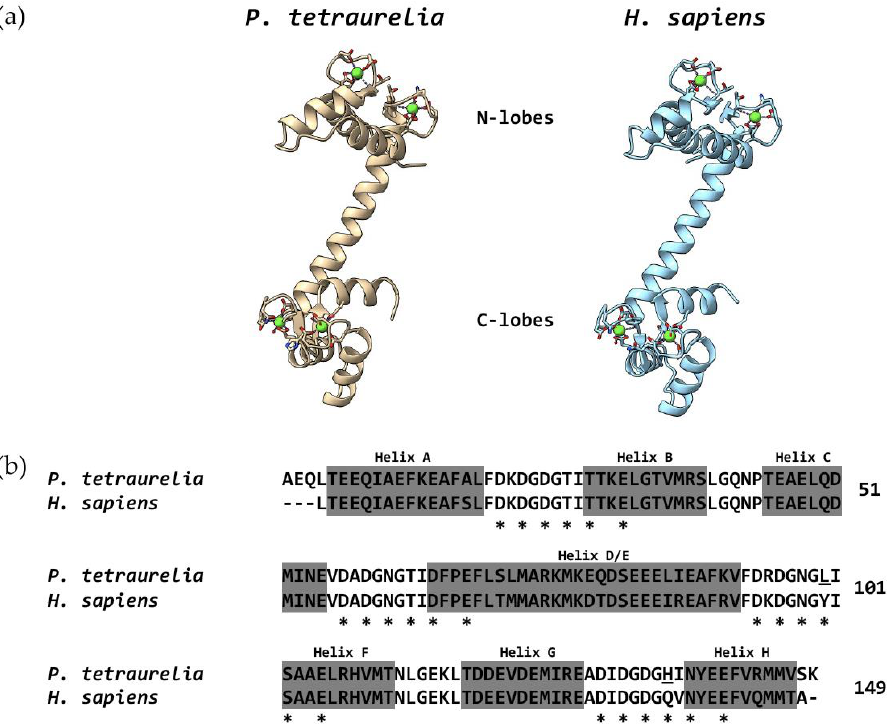
Figure 4. Tertiary structure ( a ) and sequence comparison ( b ) between the CaM of Paramecium and humans. ( a ) Sequences were downloaded from the Protein Data Bank under the accession numbers 1OSA ( P. tetraurelia ) and 1CLL ( Homo sapiens ). Drawings using these sequences were made using Chimera X [152]. Green spheres represent Ca 2+ ions. ( b ) The amino acid sequences in ( a ) were aligned using Chimera X. Note that these sequences are shorter than 149 amino acids since the crystals were obtained using non-full-length CaMs. Dashes indicate that the crystal structure lacked the amino acid at these positions. Stars indicate the amino acids that coordinate Ca 2+ ions in humans according to [15]. Underlined amino acids mark those ones that are different in Paramecium at the Ca 2+ -coordinating sites. Grey-shadowed amino acids correspond to helices (see text). Numbers at the right indicate the amino acid position in the sequence of Paramecium